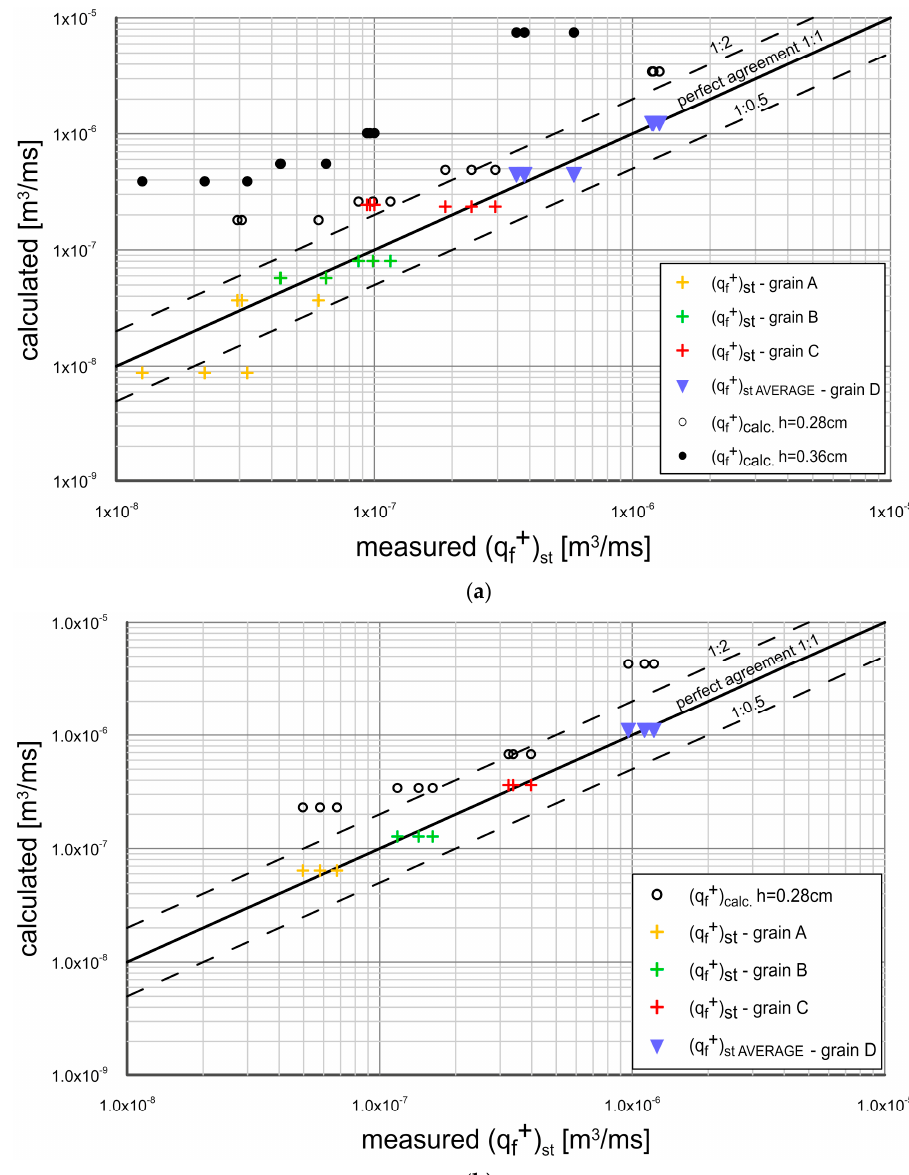
Figure 7. Comparison of calculation and measurements results q + between flat ( a ) and sloped bed ( b ) cases during the crest.